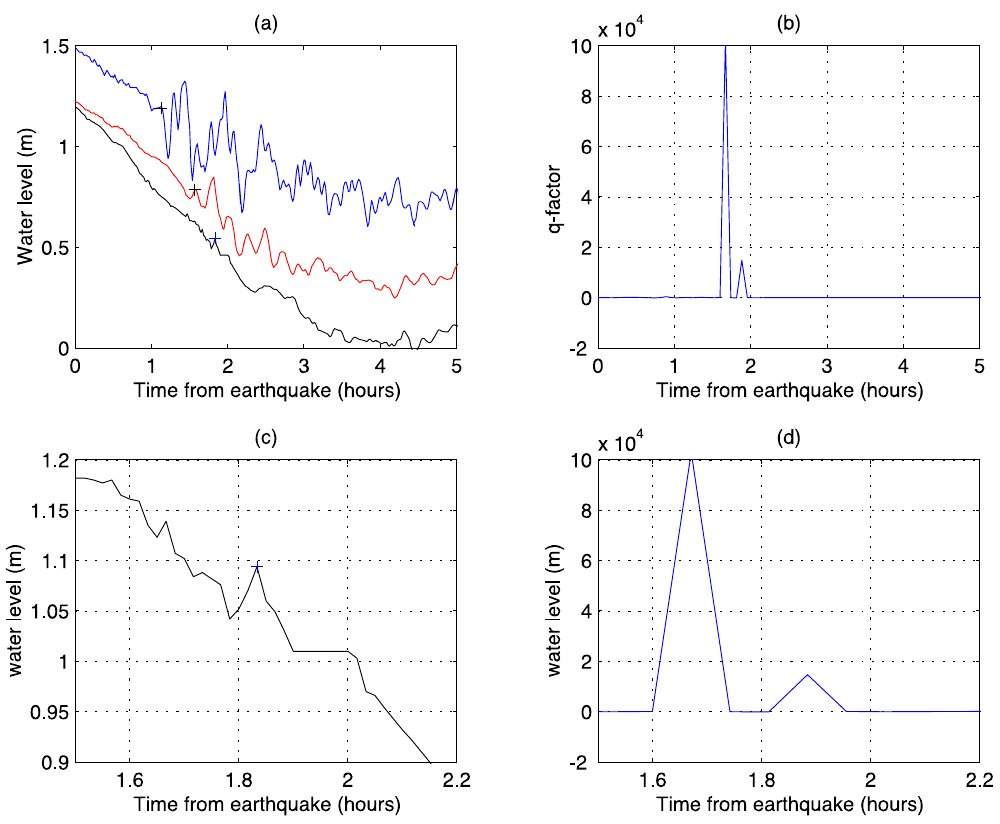
Figure 6. Tide gauge and q-factor observations 11 April 2012. ( a ) Blue: Campbell Bay. Red: Nancowry, Black: Port Blair (water levels offset down by 0.55m to separate the curve from the others). The arrival of the tsunami is indicated by ‘+’. ( b ) q-factor from the